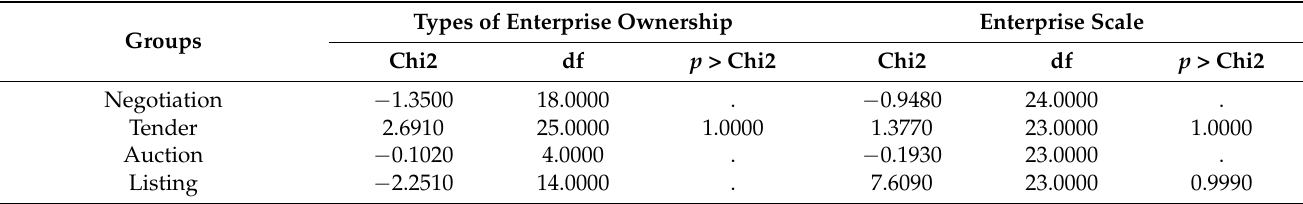
Table 13. IIA test results, 2007.